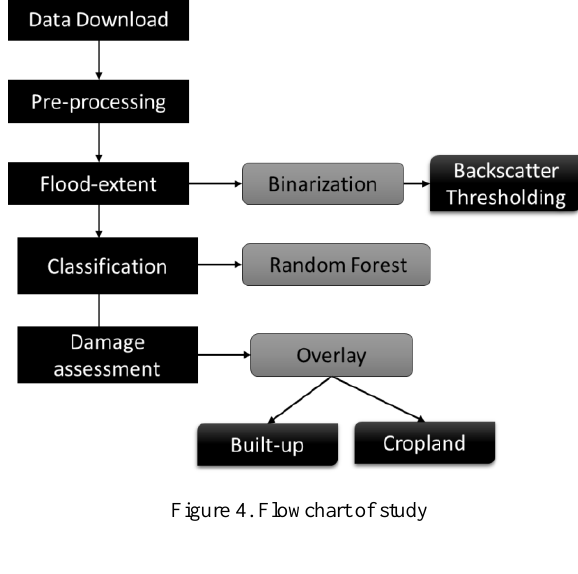
Figure 4. Flowchart of study